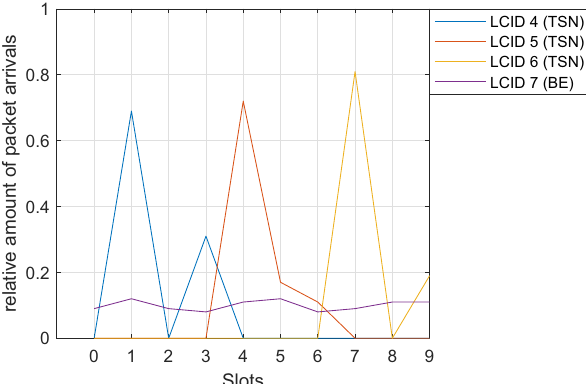
Figure 6. Density of arrival slots with dynamic LCP.